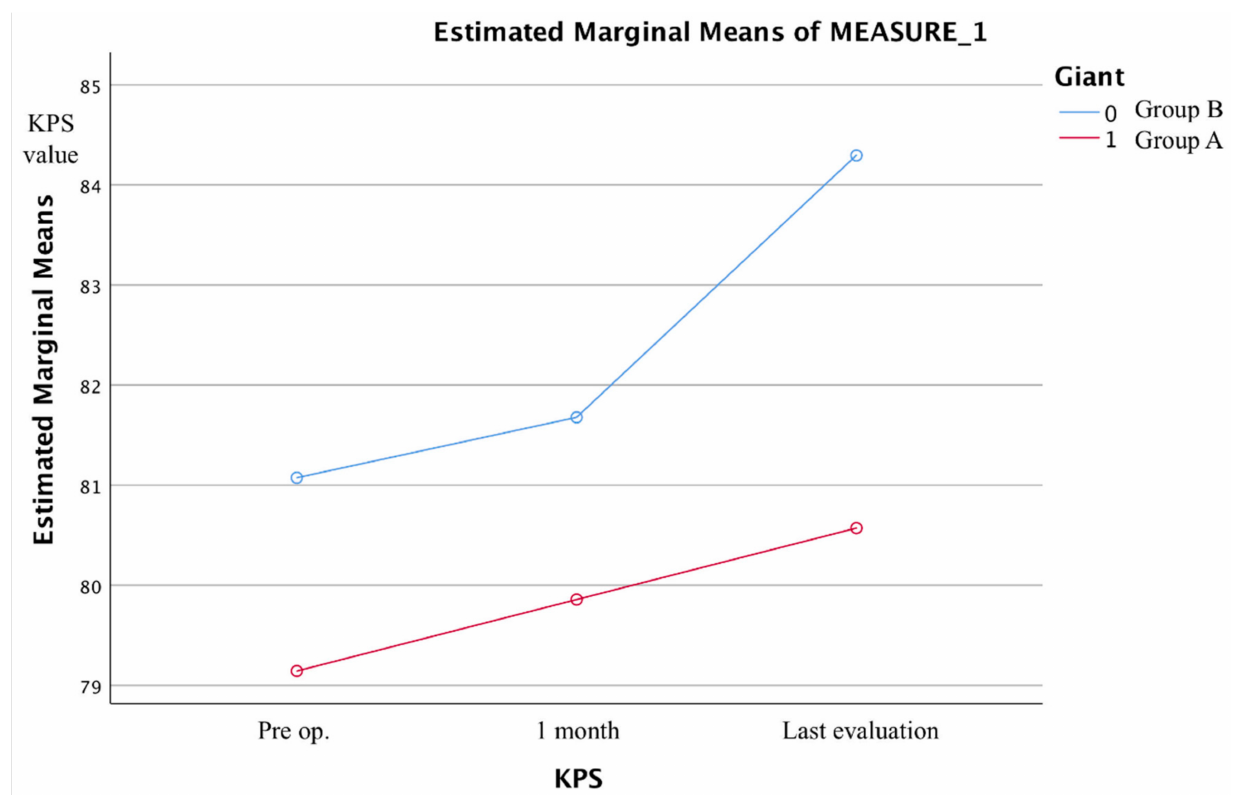
Figure 9. Results of a repeated measures test on how GIMs, independently from location and clinical debut, maintain a stable reduced performance status after